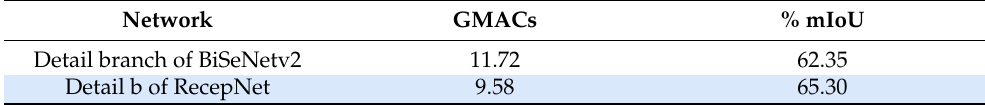
Table 8. Performance of detail path.